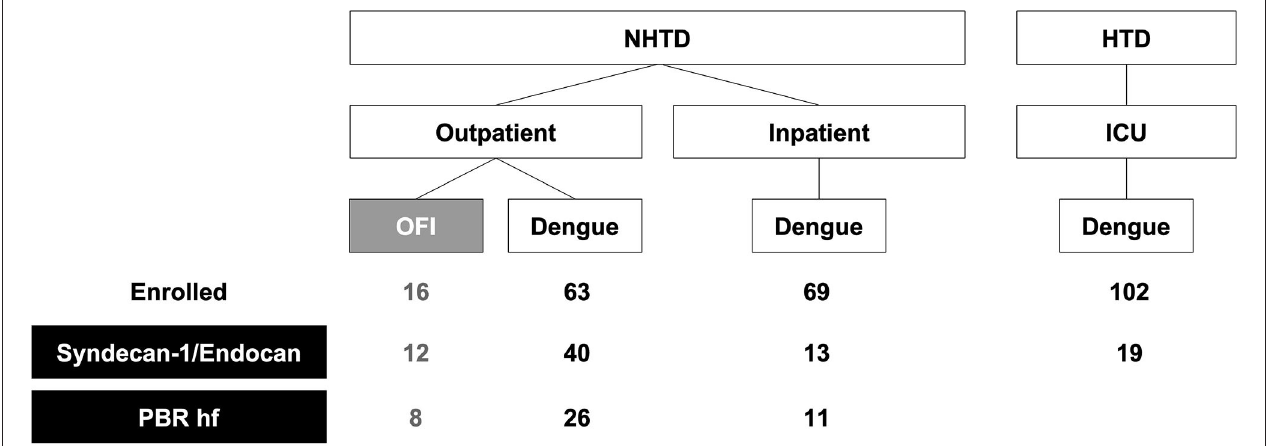
FIGURE 1 | Study flowchart. A subset of patients prospectively enrolled into an observational study on vascular function in dengue between 2013 and 2015 had Syndecan-1, endocan, and PBR hf measured. Except for one outpatient with dengue and two inpatients with dengue, all other patients with PBR hf also had Syndecan-1 and endocan measured. NHTD, National Hospital for Tropical Diseases; HTD, Hospital for Tropical Diseases; ICU, Intensive Care Unit; OFI, Other Febrile Illnesses; PBR hf, Perfused Boundary Region high